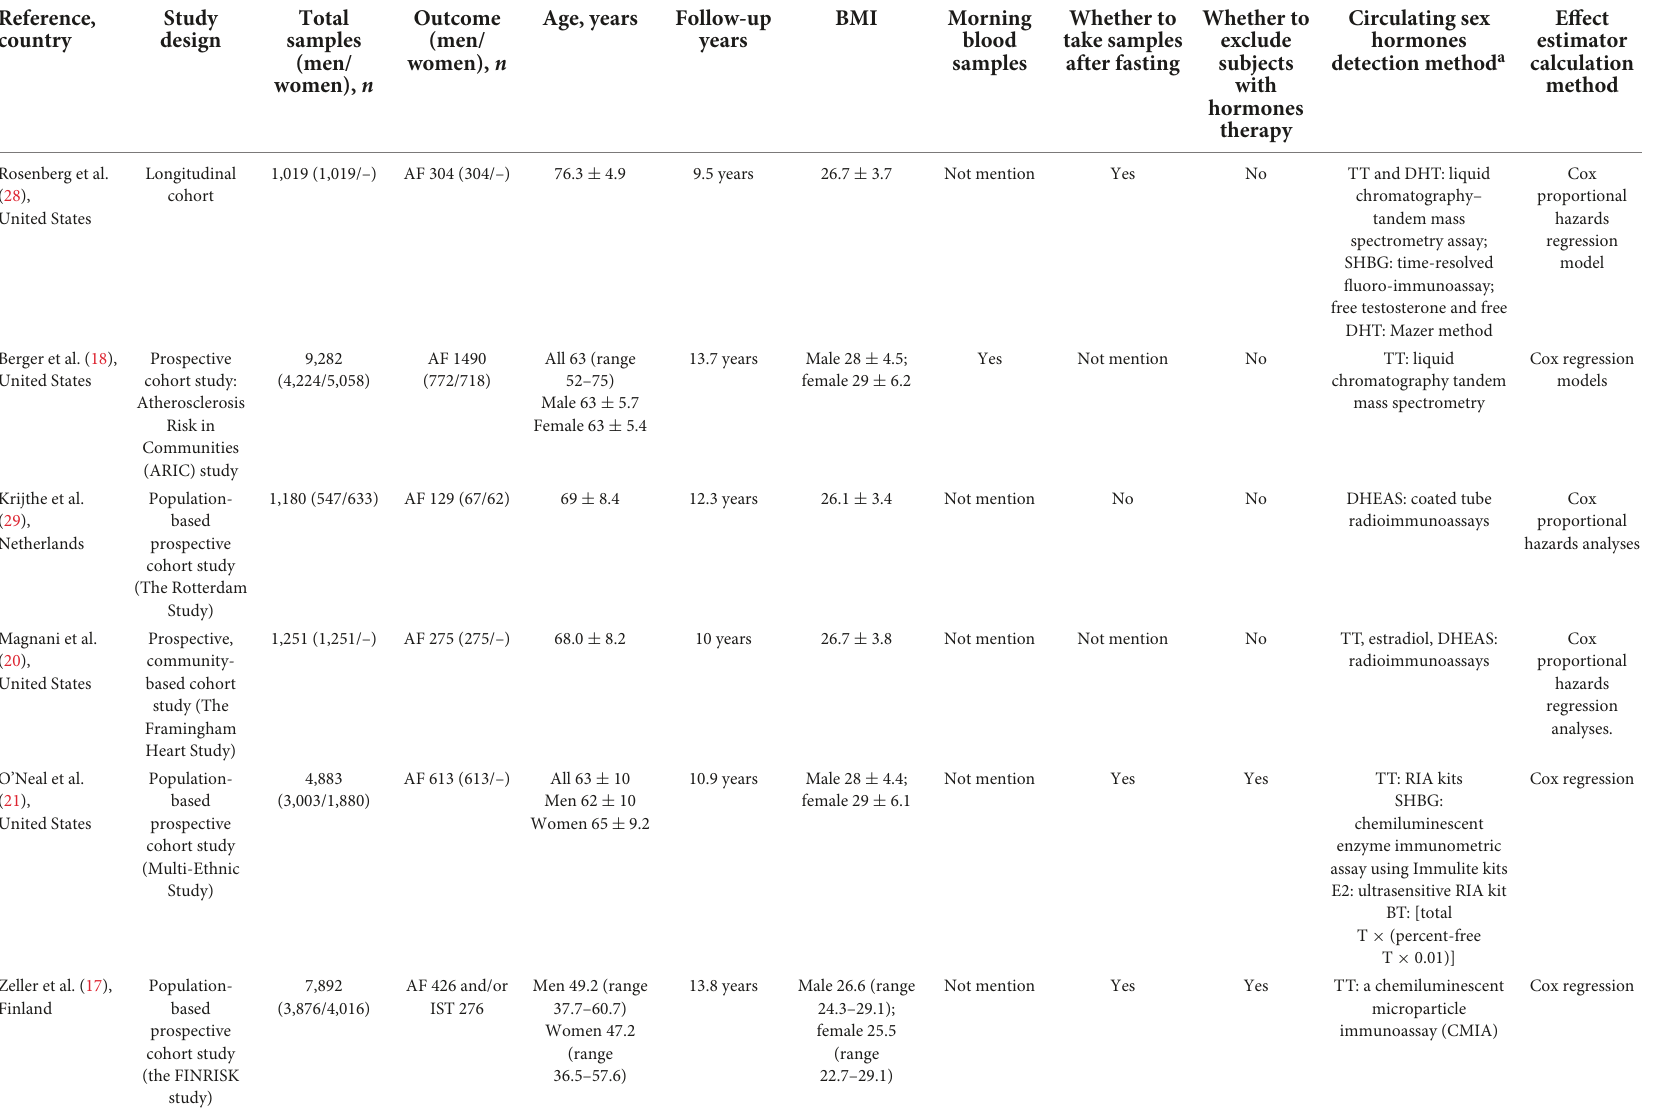
TABLE 1 General characteristics of the included cohort